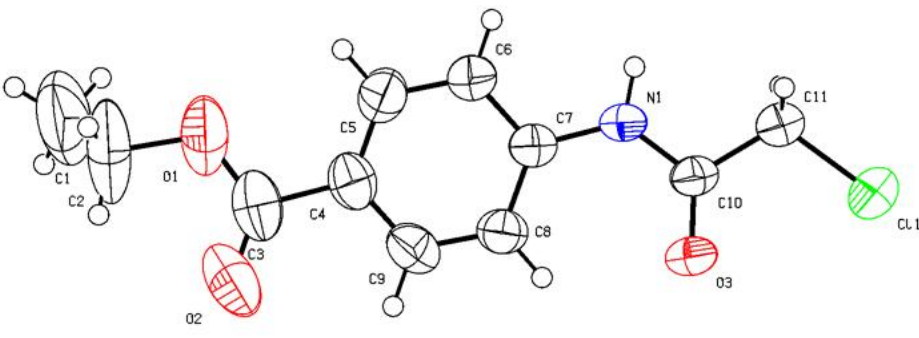
Figure 1. ORTEP plot of the X-ray crystallographic data determined for 2d . Crystallo- graphic data have been deposited with the Cambridge Crystallographic Data Centre as supplementary publication number CCDC 874278 [28].